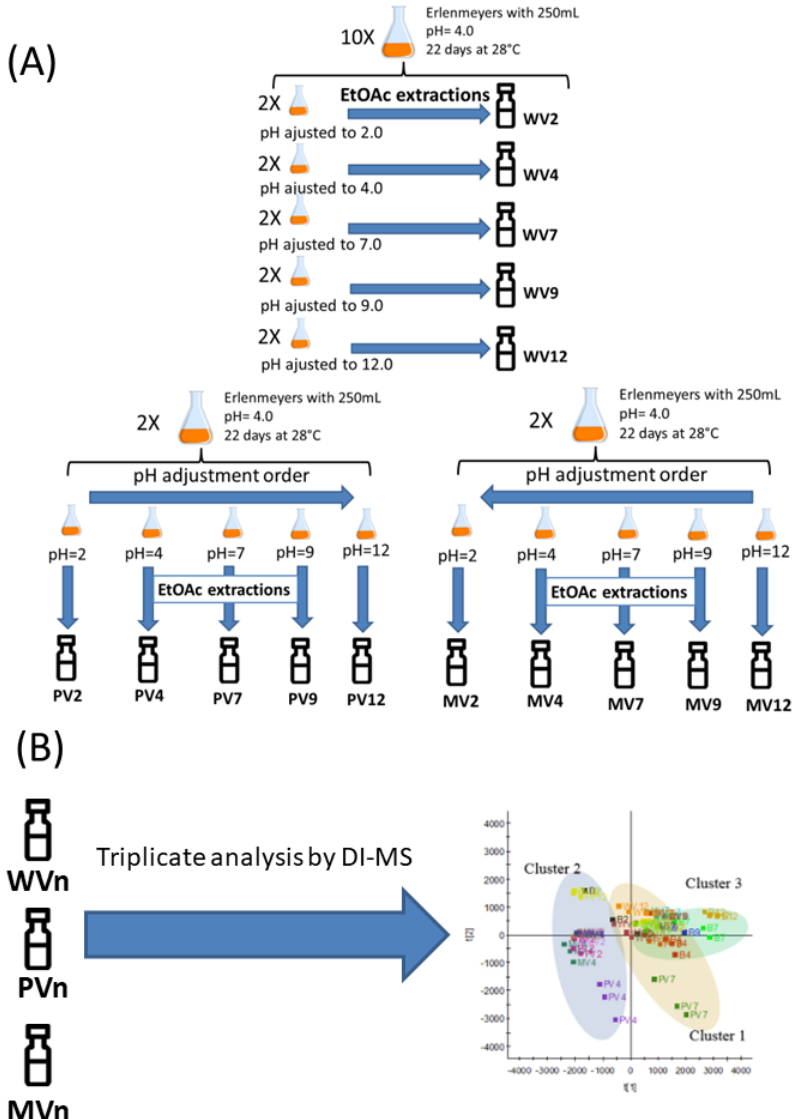
Figure 6. Experimental design: ( A ) Varying the pH of fermented broth. WV samples: the pH of the fermented broth was adjusted, after which the adjusted broth was extracted with ethyl acetate extraction; the broth was discarded after partitioning. PV and MV fermented broths: pH was adjusted to 2 and 12, respectively, after which they were extracted with ethyl acetate after adjusting the pH to 4 or 9, respectively, without discarding the broth. ( B ) The obtained vials (two per sample) were analyzed by DI-MS in triplicate.